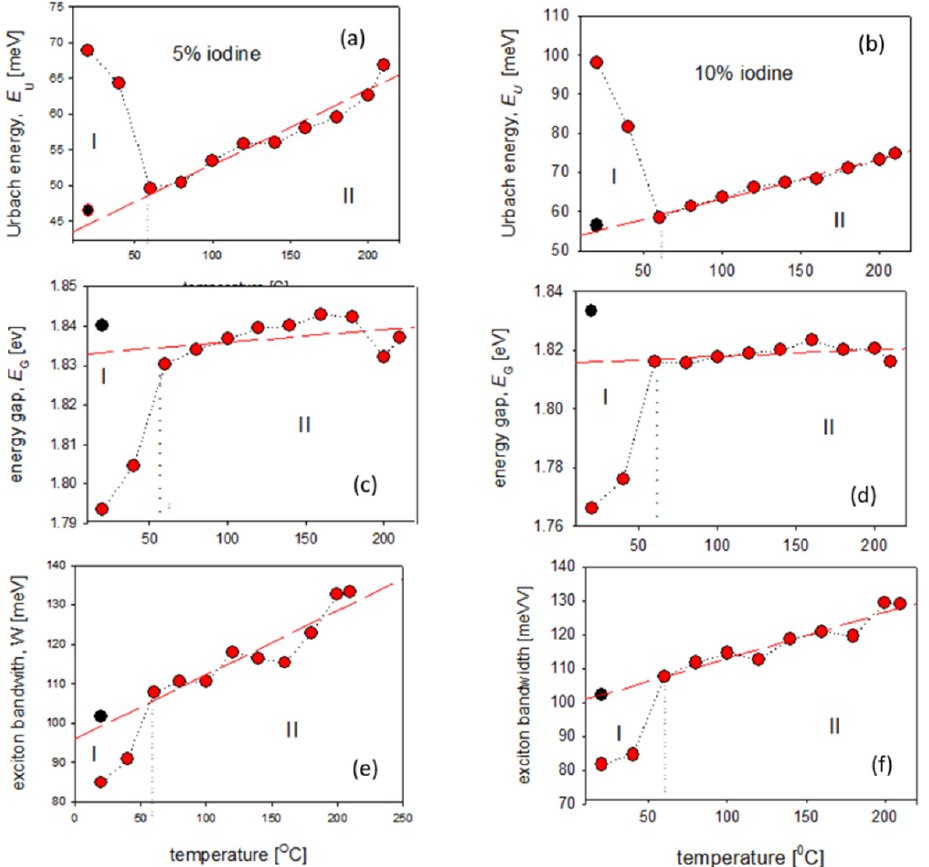
Figure 5. Temperature dependences of absorption edge parameters ( E U , E G ) and the exciton bandwidth ( W ) for 5% ( a , c , e ) and 10% ( b , d , f ) iodine-doped P3HT films; (black points in figures denote the values at 20 ° C, after thermal treatment).